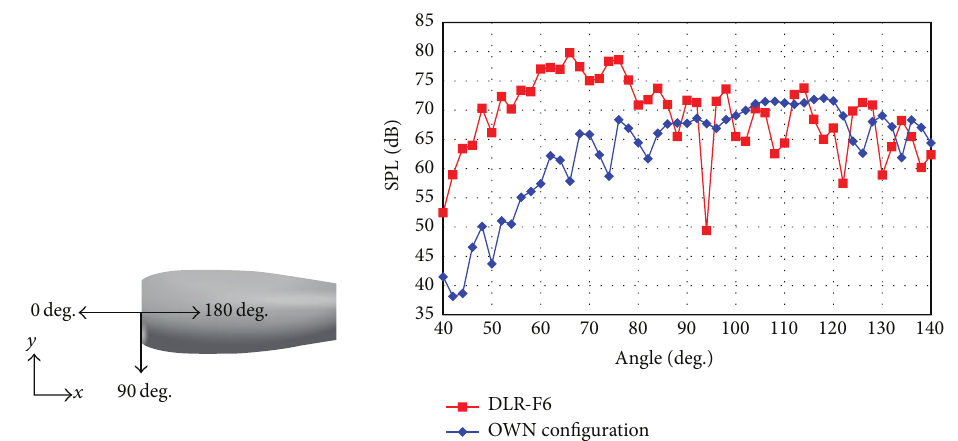
Figure 18: The sound pressure level (SPL) distributions at a radius of 𝑟 = 10 D based on the center of front face of nacelle.